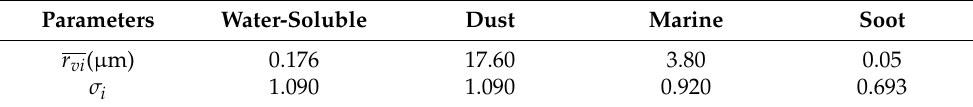
Table 5. SRA model parameters for different aerosol types